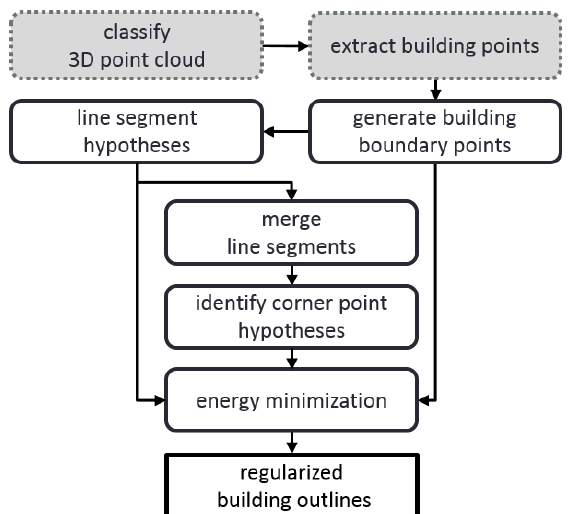
Figure 1. Workflow for regularizing building footprints.